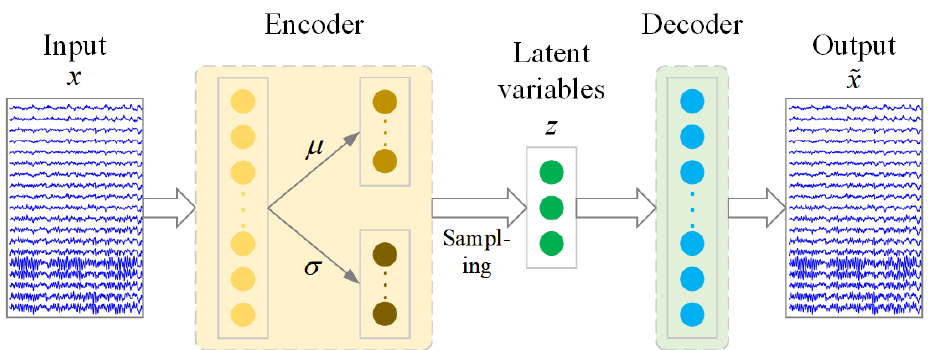
Figure 2. Neural network architectures of VAE. The encoder is in charge of encoding the high-dimensional input ( x ) into a low-dimensional representation ( z ), and the decoder is in charge of reestablishing the input data ( x ) on the basis of the low-dimensional representation ( z ).